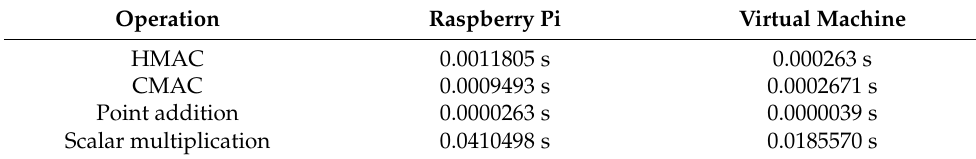
Table 5. Average computing time on Raspberry Pi and virtual machine in experiment